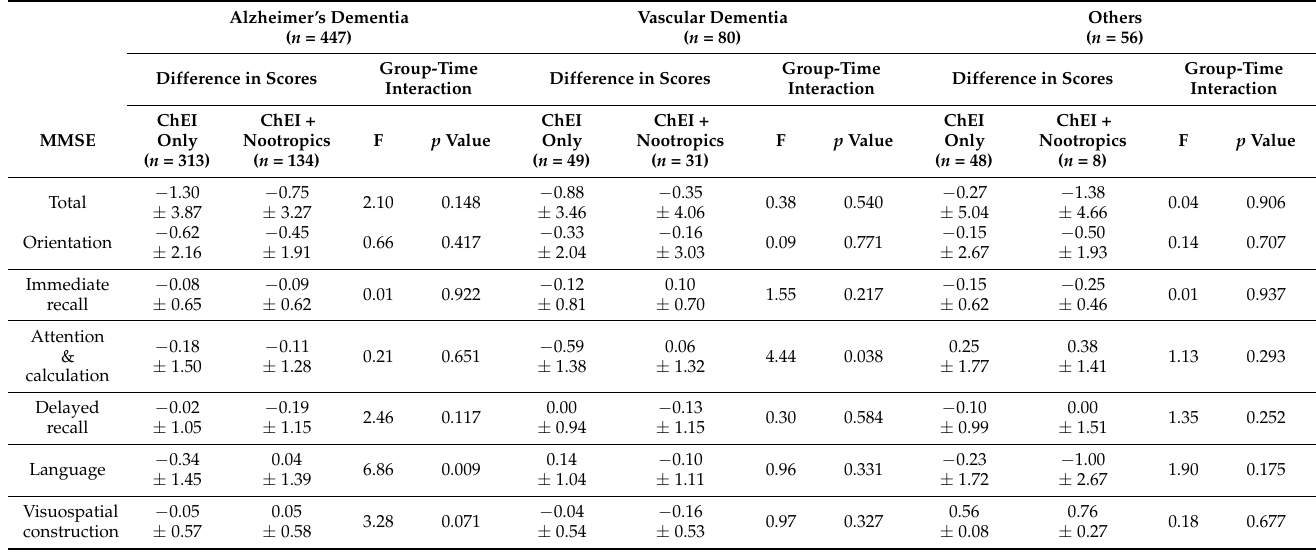
Table 3. Results of mixed model analyses 1 for mini-mental state examination (MMSE) among the three dementia subgroups.